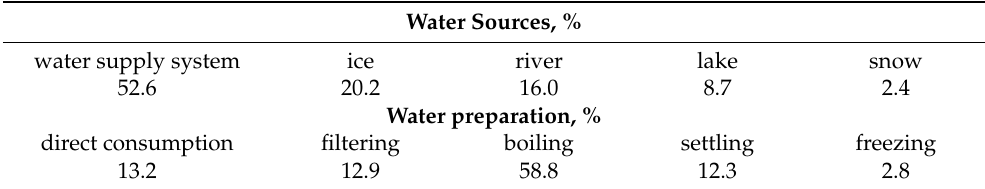
Table 3. Water sources and water preparation used by the rural residents of the Arctic zone of Western Siberia ( n = 552).